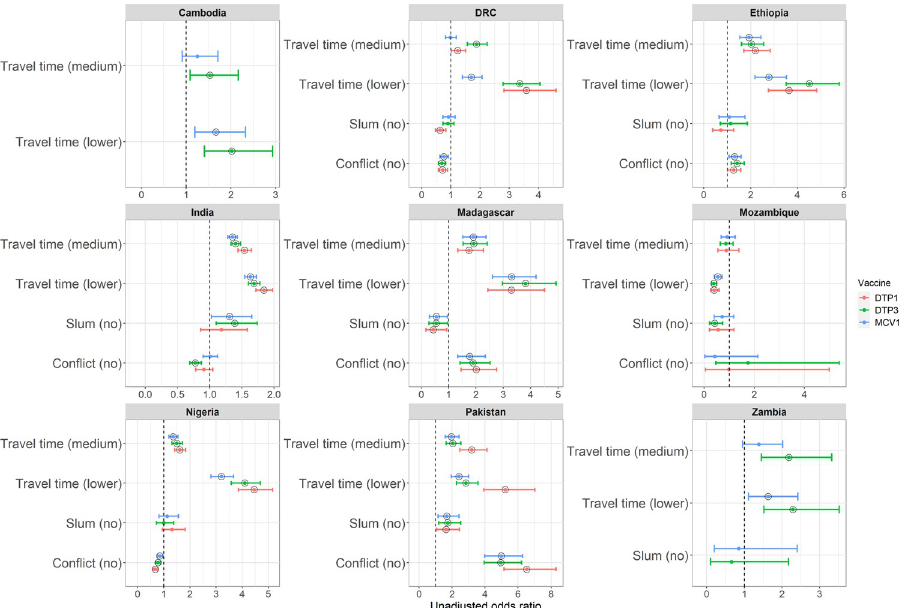
Fig 2. Plots of crude/unadjusted odds ratios and corresponding 95% CIs. The plots are based on bivariate analyses between each of the community-level variables (remoteness measured using travel time to the nearest city, urban slum and conflict area) and receipt of DTP1, DTP3 and MCV1 vaccinations. The vertical dotted lines mark the odds ratio of 1. The black circles show significant associations. Note that the reference category for travel time is